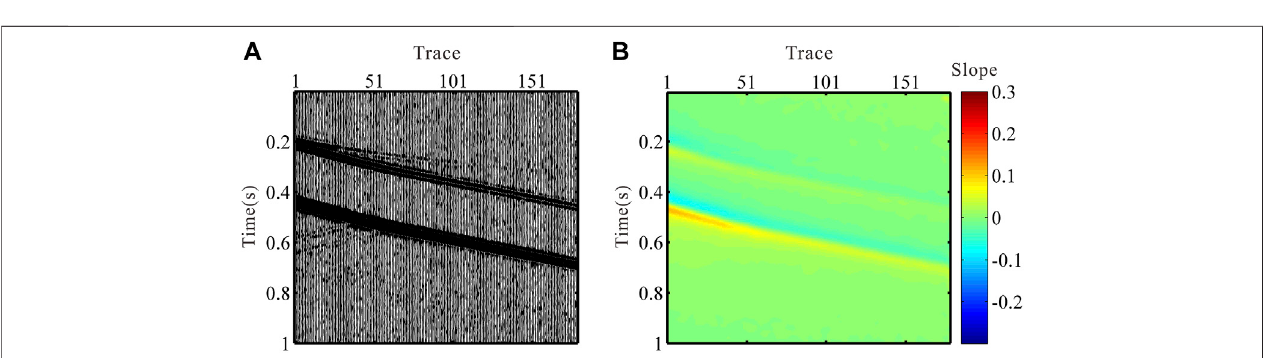
FIGURE 4 | (A) Scalar fi eld of the horizontal components of synthetic VSP data and (B) corresponding slope of the scalar fi eld.